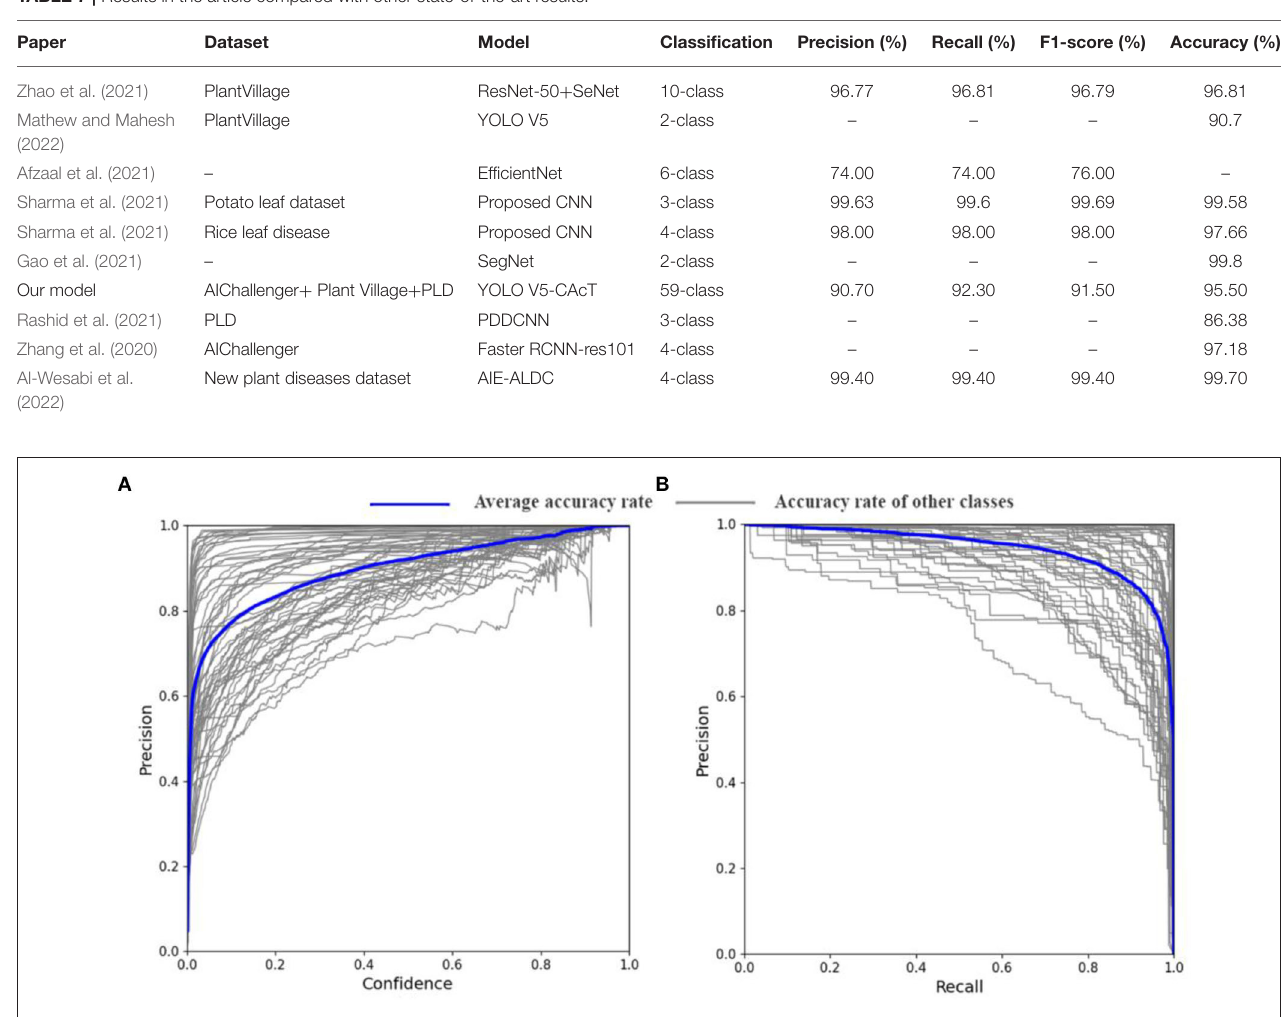
FIGURE 9 | Confidence accuracy curve and recall accuracy curve. (A) Precision-confidence curves of the YOLO V5s-CAcT3 model on the PFD dataset. (B) PR curves of YOLO V5s-CAcT3 model on the PFD